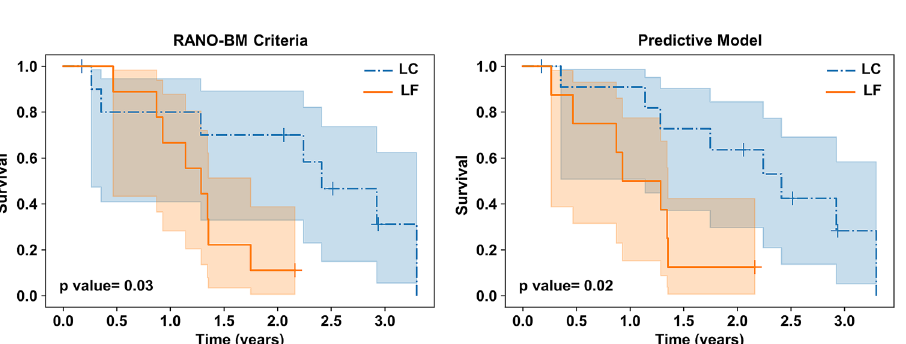
Figure 5. The survival curves of the patients treated with SRT and had lesions with LC versus LF outcome determined at the last patient follow-up based on the RANO-BM criteria (left), and at pre-treatment using the predictive model with the optimal quantitative MRI biomarker